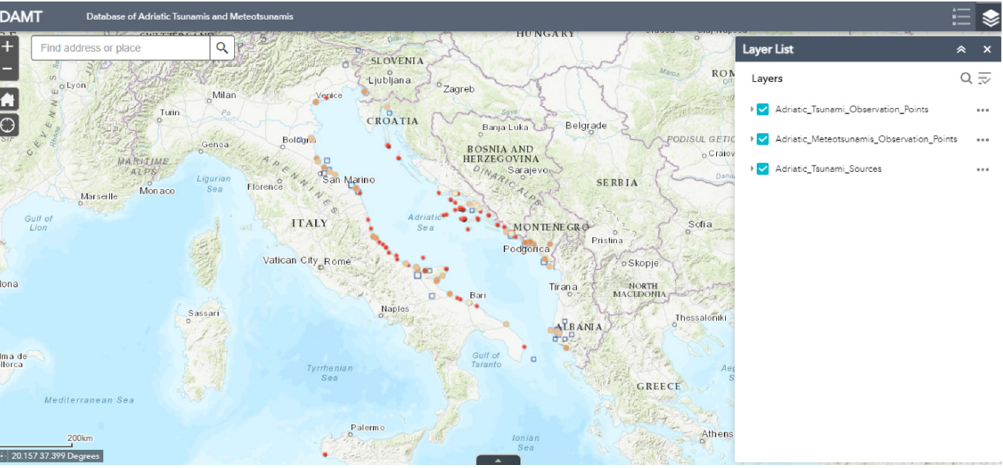
Figure 1. Main screen of the DAMT WebApp. On the right, the layer list is shown. Check marks indicate that all levels are highlighted in the map. Blue squares are tsunamigenic sources. Beige- shaded points are tsunami observation points. Red points are meteotsunami observation points.